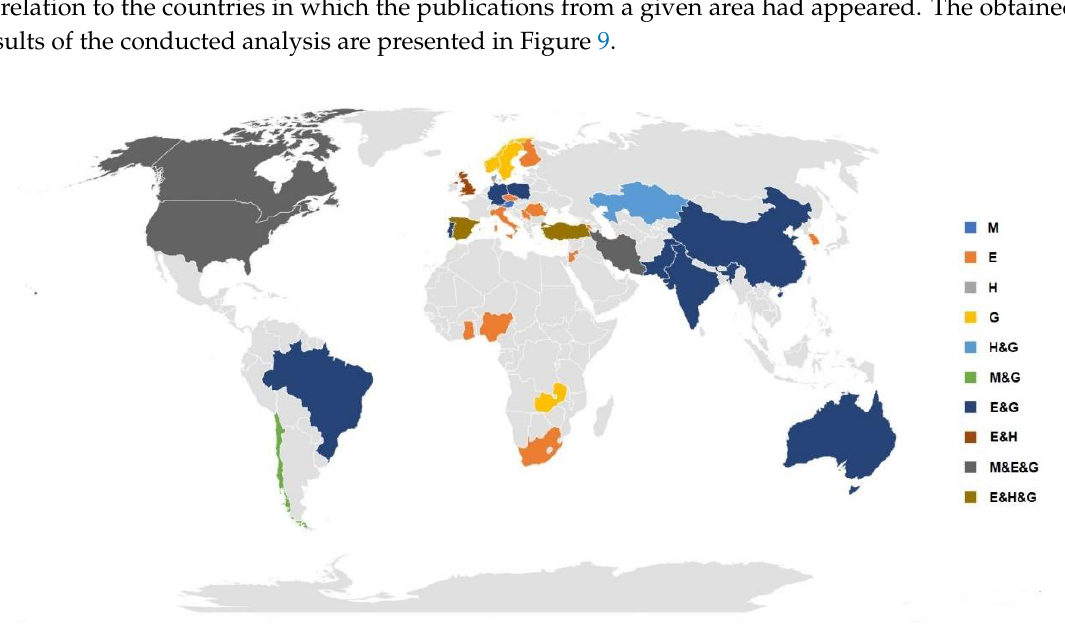
Figure 9. The thematic areas of publications appearing in a given region (where: M—machine; E—environment; H—human factor; G—general).